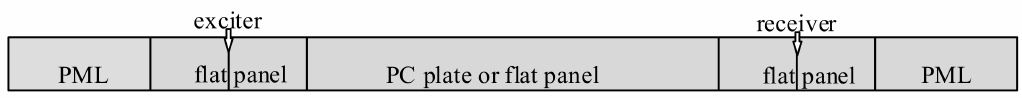
Figure 2. The simulation model for